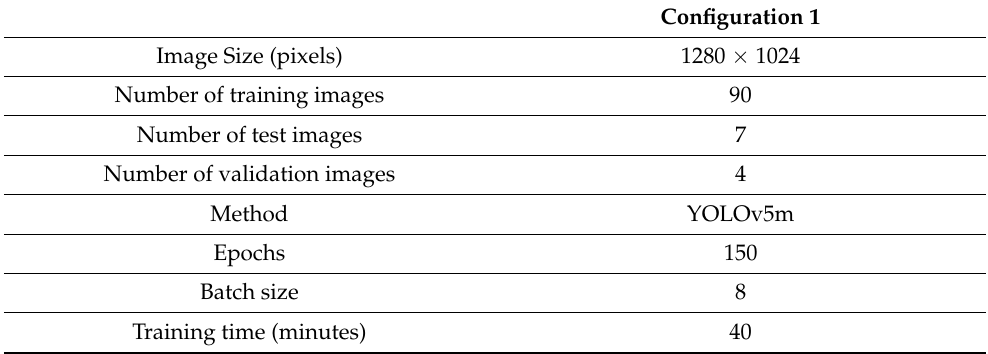
Table 7. Training